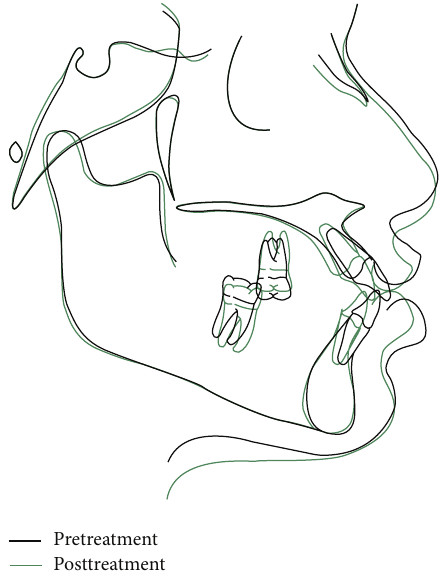
Figure 9: Cephalometric superimposition of pre- and posttreat- ment lateral